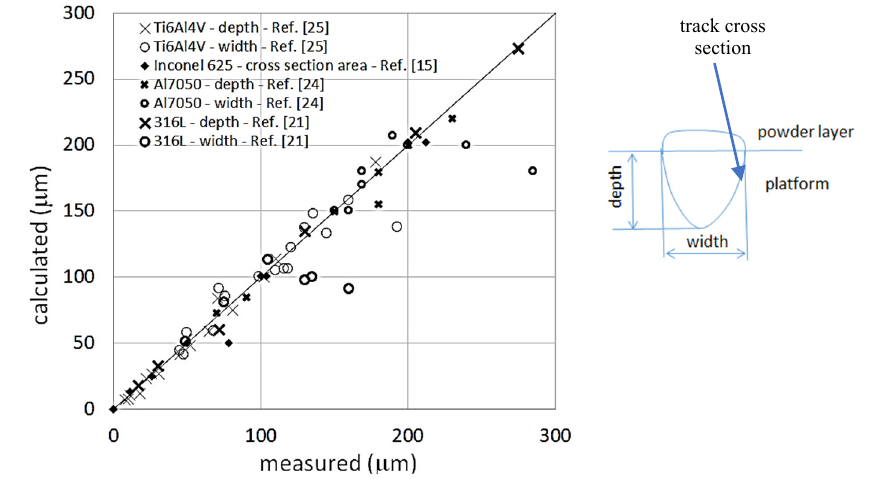
Figure 4. Fitted values of the multiplying parameter C k .